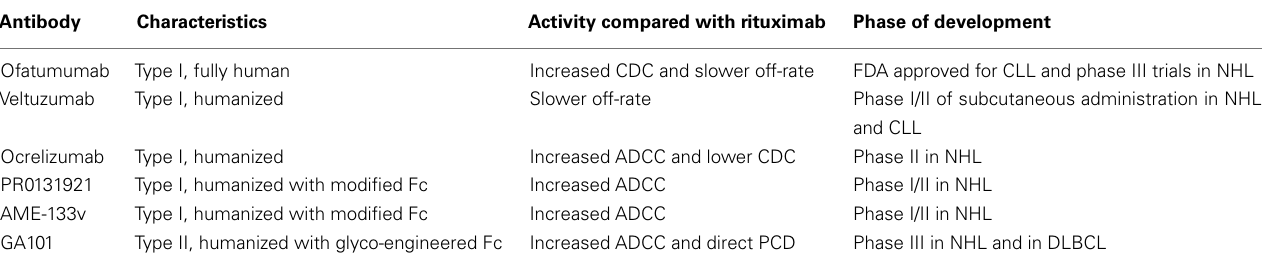
Table 1 | New generation anti-CD20 mAbs in clinical